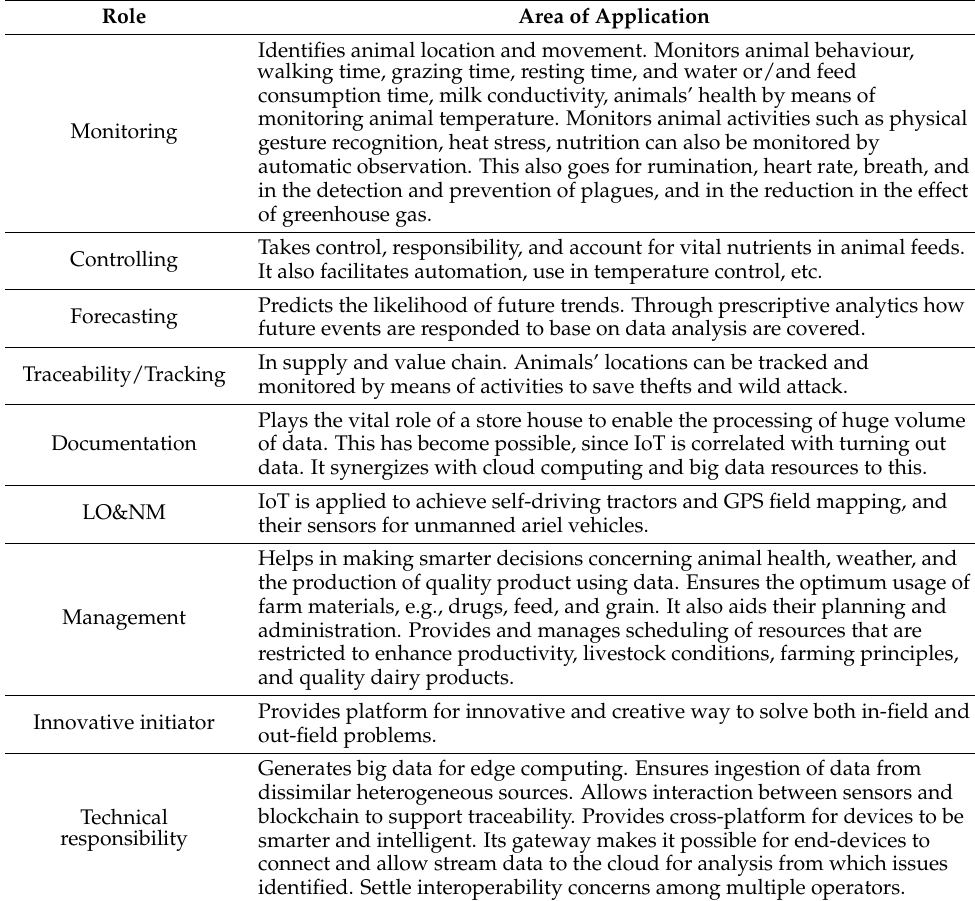
Table 8. Additional IoT’s role in livestock management (a summarized version of [37,71,142–147]).